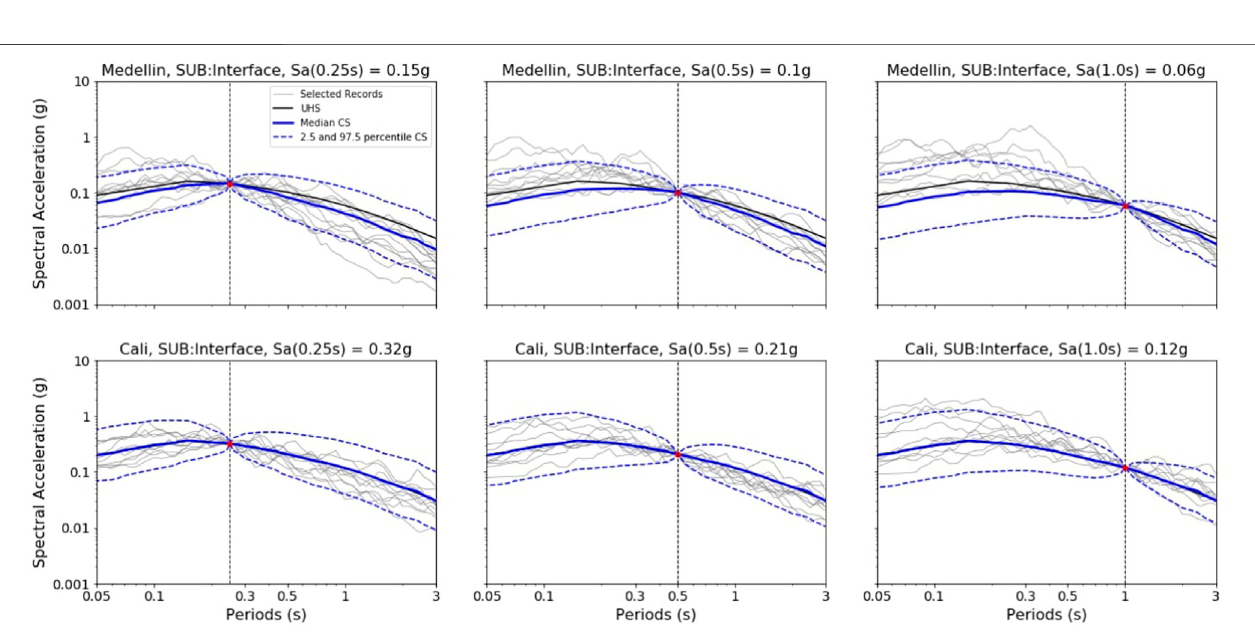
FIGURE 7 | Conditioned spectra (CS), response spectra from the records selected, and uniform hazard spectra (UHS) for subduction interface at the intensity measure level of 10% probability of exceedance in 50 years for Sa (0.25 s) left, Sa (0.5 s) center, and Sa (1.0 s) right for the cities: Medellín (top) and Cali (bottom). Continuous blue thick line: median CS. Dash-lines: 2.5 and 97.5 CS percentiles. Continuous grey thin lines: records selected.